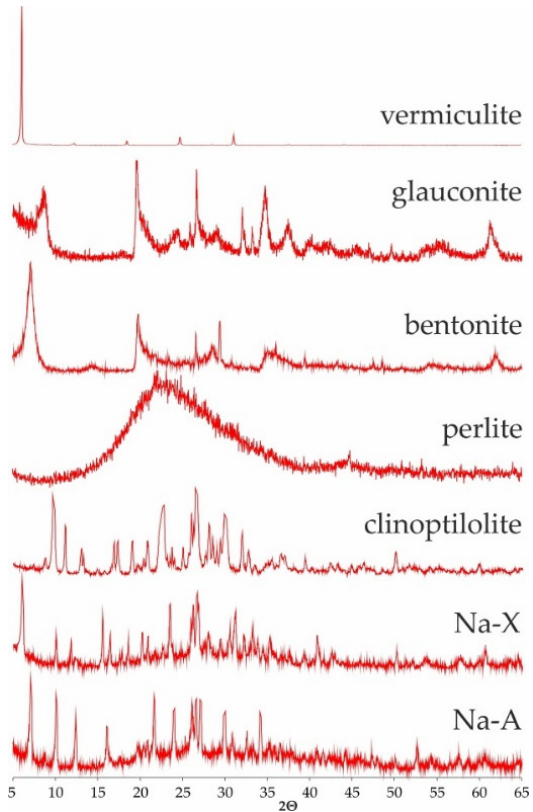
Figure 1. Diffractogramms of studied sorbents. Figure 1. Di ff ractogramms of studied sorbents.